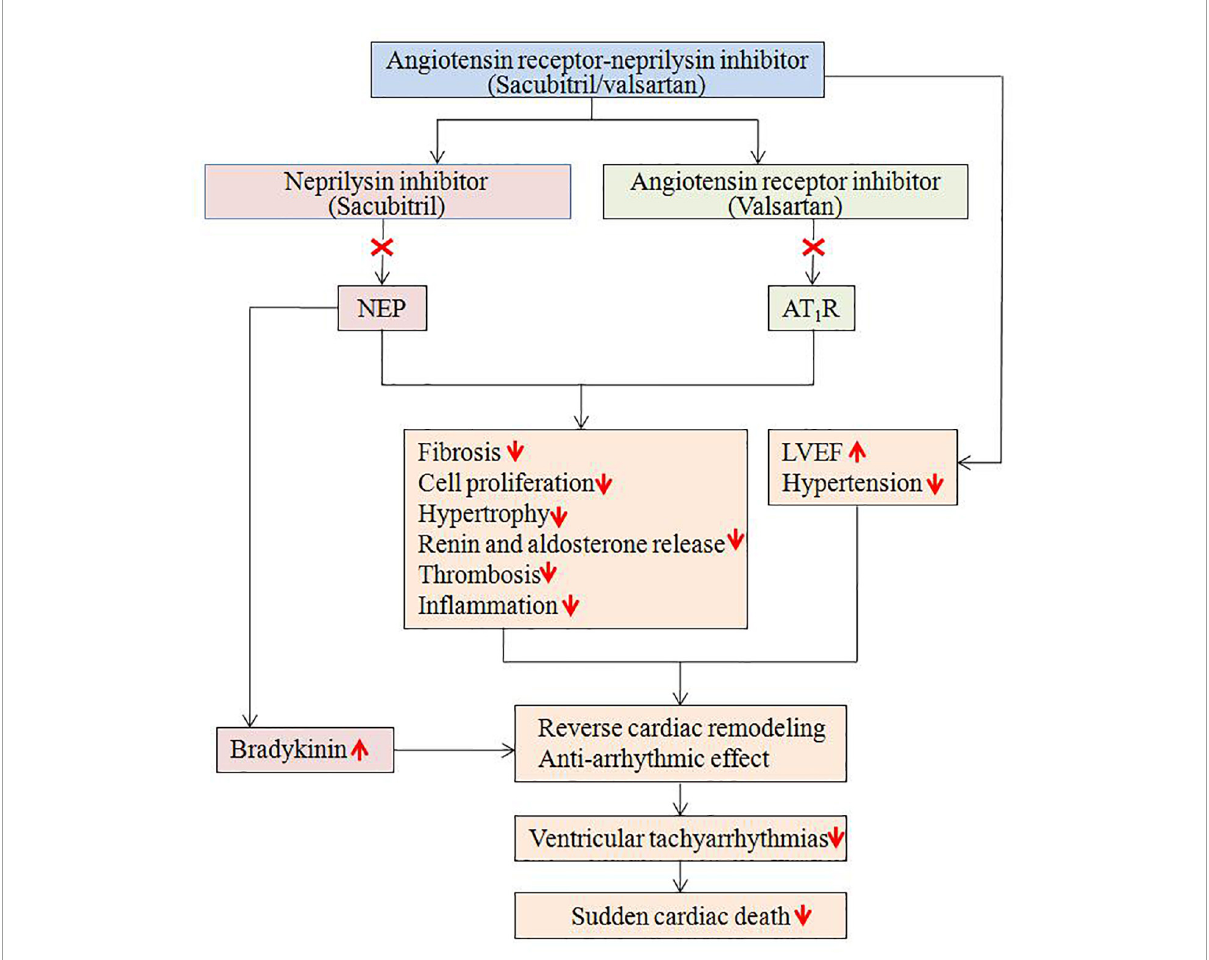
FIGURE6 Potential mechanisms regarding the anti-arrhythmic effects of sacubitril/valsartan. AT1R, angiotensin II type1 receptor; LVEF, left ventricular ejection fraction; NEP,